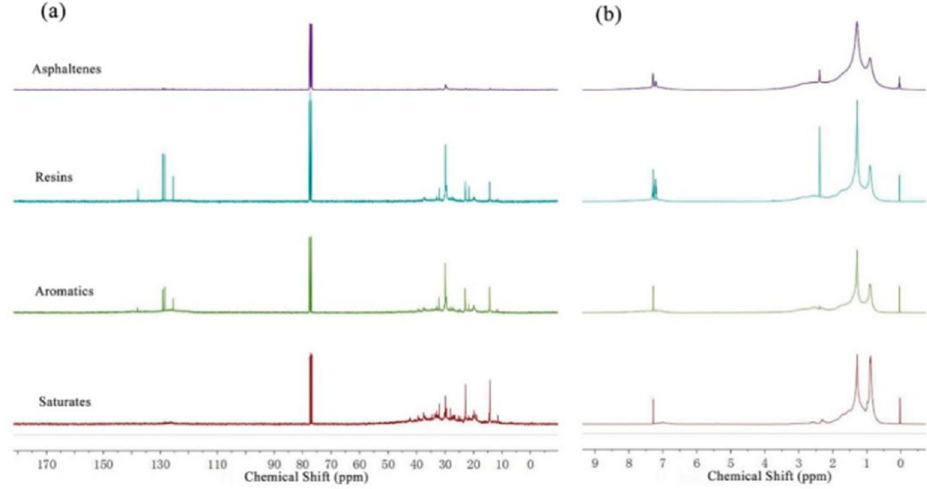
Figure 8. 1 H NMR and 13 C NMR spectra of four fractions: ( a ) 1 H NMR; ( b ) 13 C NMR.